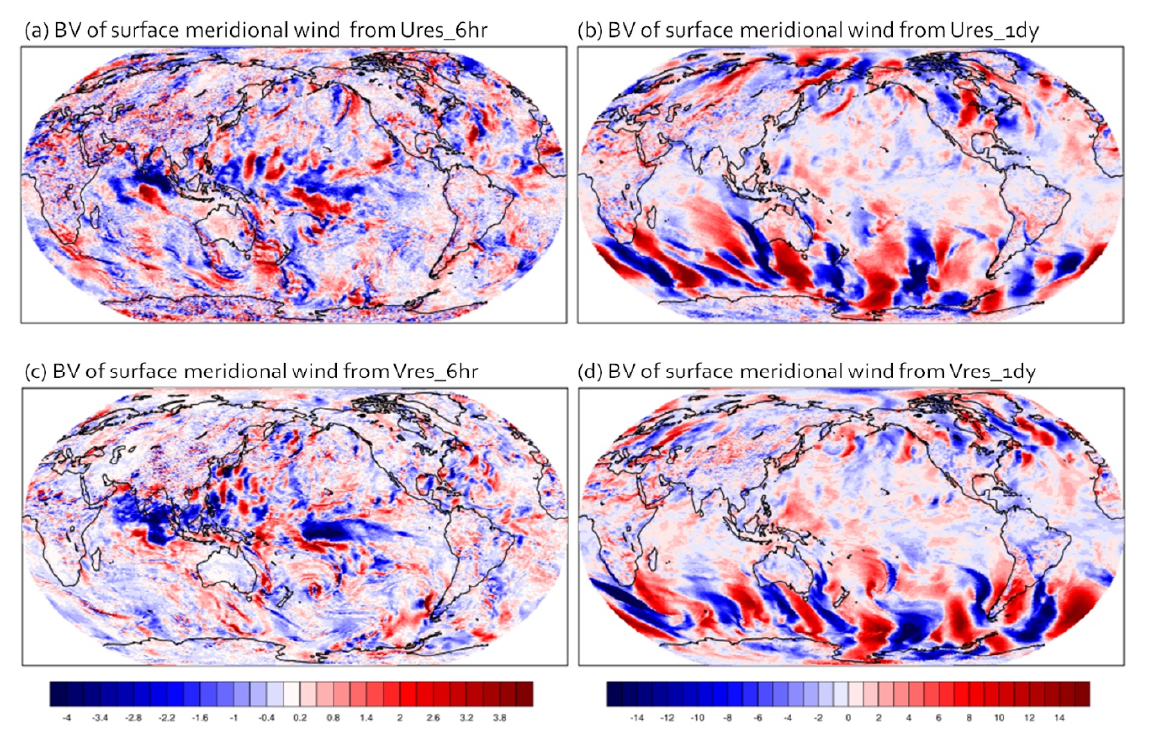
Figure 8. The same as Figure 6 except for the variable of surface meridional wind (m/s).